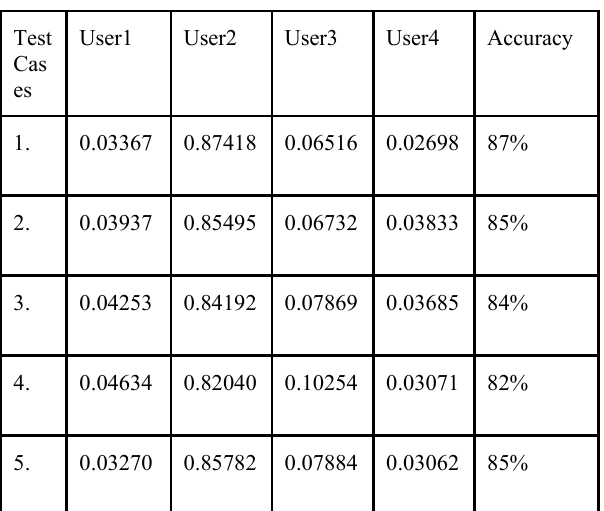
Table 2. Results for Facial recognition of User2 without